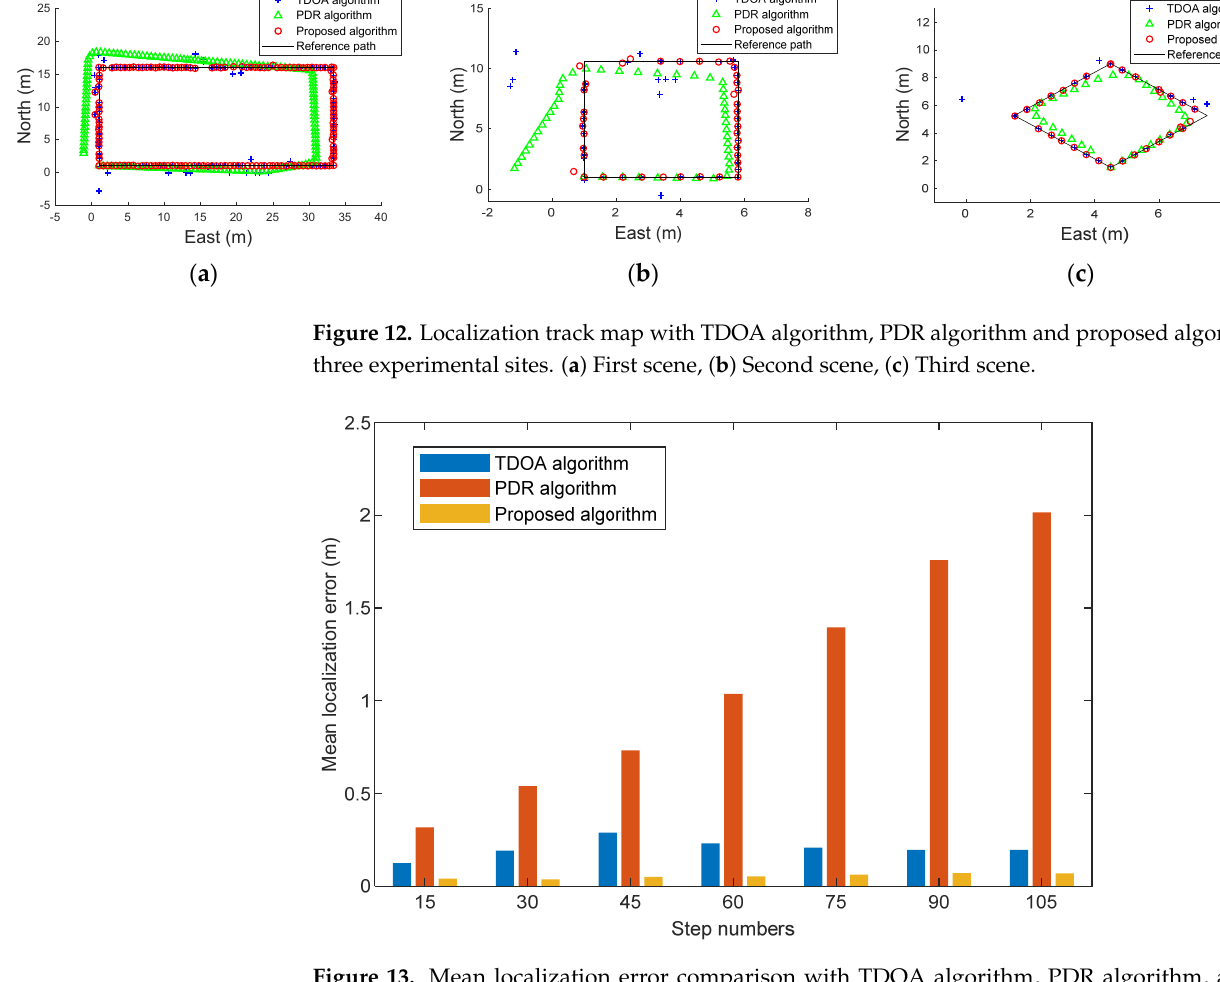
Figure 13. Mean localization error comparison with TDOA algorithm, PDR algorithm, and the proposed algorithm at different step numbers (First scene).